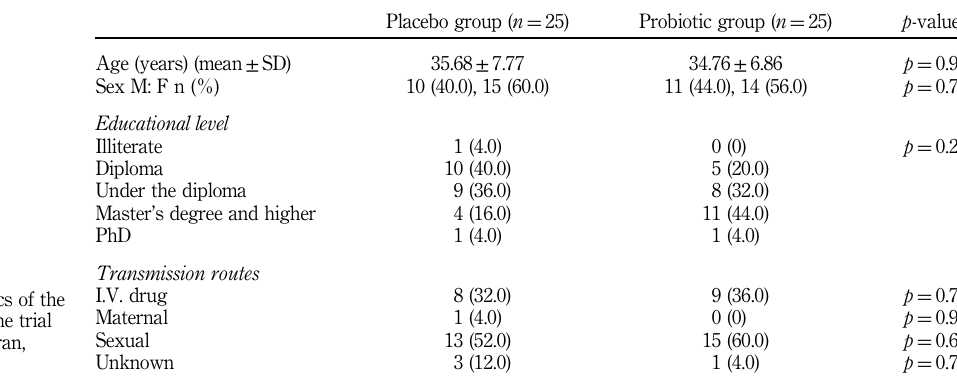
characteristics of the patients in the trial